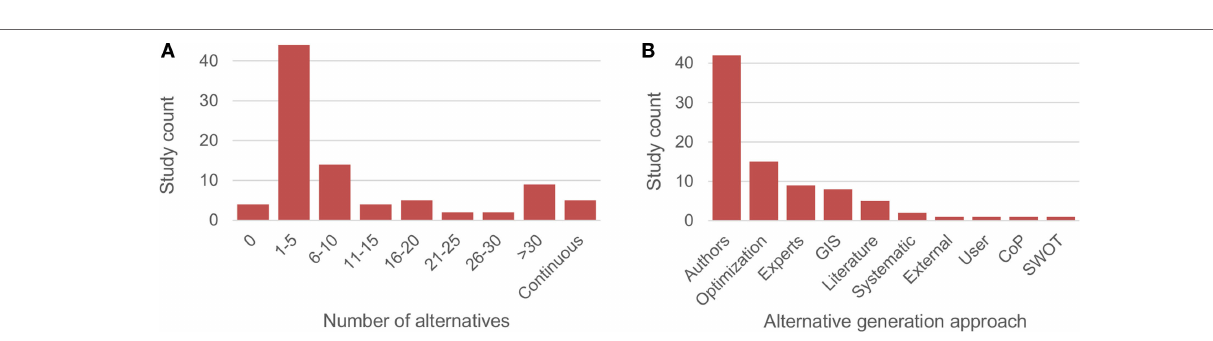
FiGURe 6 | Alternative results from the review . (A) Number of alternatives analyzed by the reviewed studies. The bin “ > 30” includes numbers of alternatives between 30 and 7000, whereas “Continuous” includes studies that relied on Geographic Information System methods. (B) Distribution of alternative generation approaches adopted by the reviewed studies.